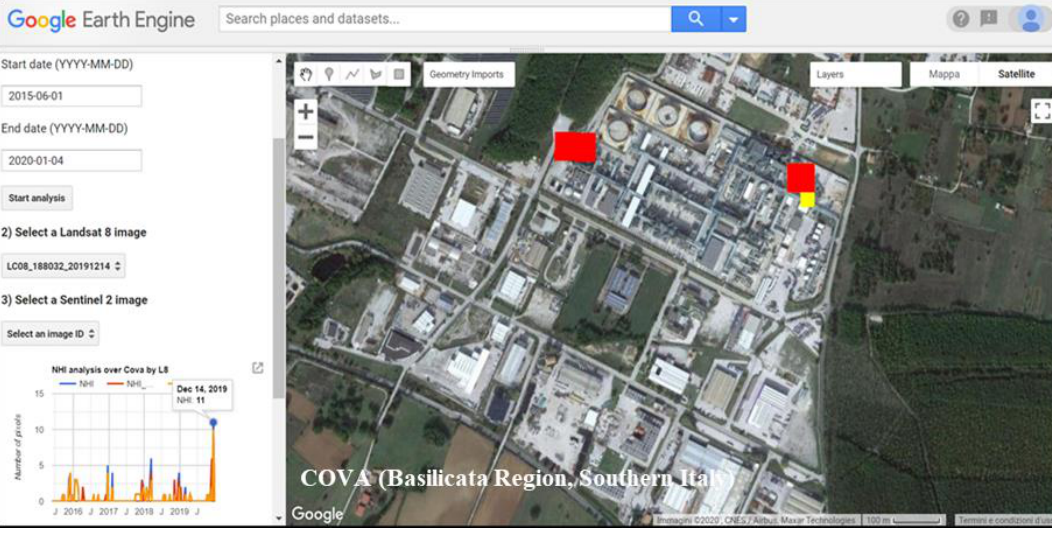
Figure 14. Thermal anomalies (red / yellow pixels) identified by NHI, under the GEE platform, at Val d’Agri (Southern Italy) Oil Center (Basilicata Region; Southern Italy) from Landsat-8 OLI data of 14 December